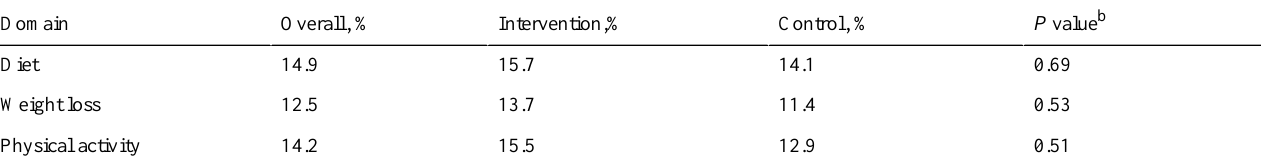
Table 6. Stages of change a : moving from inactive to active stage by intervention at follow-up.